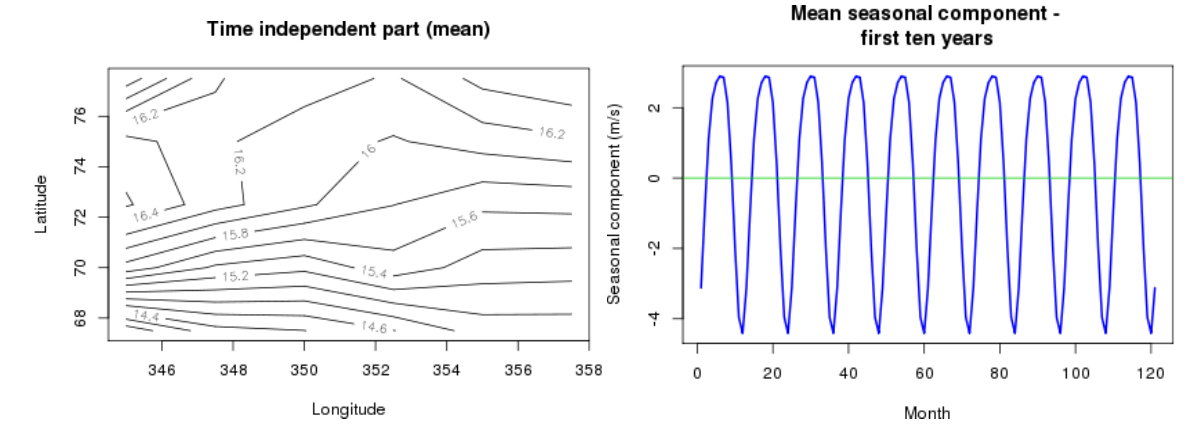
Fig. 11. Results from the model applied to an alternative area: spatial field and seasonal factor.